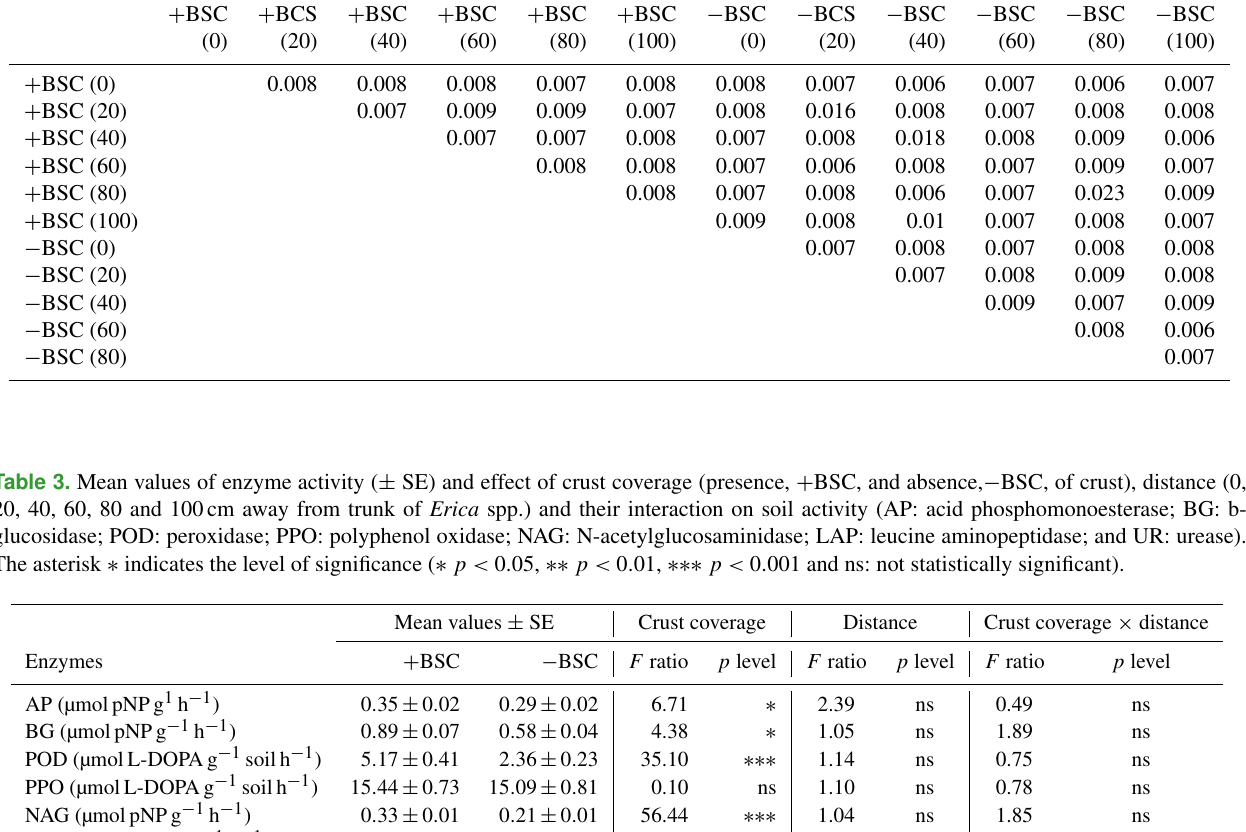
Table 2. ANOSIM ( p values) applied on individual PLFAs based on the Bray–Curtis index of similarity to detect dissimilarities in microbial community composition between different local communities (at different distances from the trunk of Erica spp. shrubs in crust-covered ( + BSC) and uncrusted ( − BSC) soils). For p values < 0 . 05 dissimilarities are statistically significant. + BSC